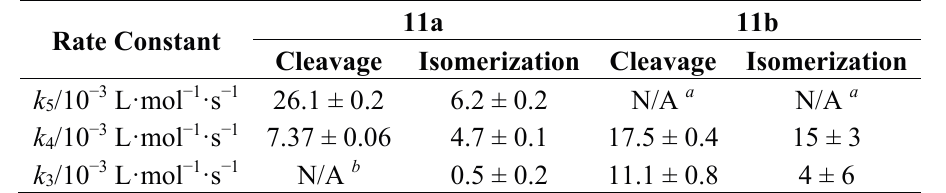
Figure 4. pH-rate profiles for the ( A ) 11a - and ( B ) 11b -catalyzed cleavage (  ) and isomerization (  ) of UpU; T = 90 °C, I (NaClO 4 ) = 1.0 mol·L − 1 . Table 1. Second-order rate constants for the cleavage and isomerization of UpU, catalyzed by the tri-, tetra- and pentacationic forms of 11a and 11b ; T = 90 °C, I (NaClO 4 ) = 1.0 mol·L − 1